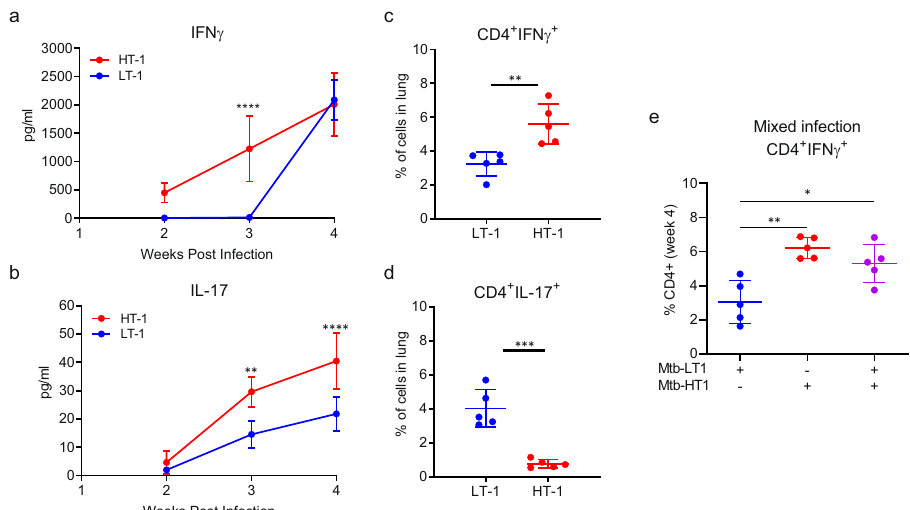
Fig. 4 T cell response is skewed towards Th17 in Mtb-LT infection. C3HeB/FeJ mice were infected with ~100 CFU of the indicated strain via Glas-Col aerosol exposure. IFN γ ( a ) and IL-17A ( b ) protein expression at weeks 2, 3, and 4 post infection was determined by ELISA. Single cell suspensions prepared from the lungs were stimulated for 3 h with Mtb-H37Rv lysate and mycobacterial ESAT-6 and CFP-10 peptide pools and stained with a panel of cell surface antibodies, fi xed and permeabilized, and then stained with a panel of intracellular antibodies. Data are presented as percent of IFN γ + CD4 + ( c ) or IL-17 + CD4 + ( d ) T cells. In a separate experiment Mtb-HT1, Mtb-LT1, and dual Mtb-HT1/LT1 infected mice were evaluated for IFN γ T cells at week 4 post infection ( e ). Data are presented as mean values + / − SD. Source data are provided as a Source Data fi le. Sample size of n = 5 mice was included in each group. Signi fi cance was determined using two-way ANOVA with Bonferroni post-test ( a and b ), unpaired t test ( c and d ) or one-way ANOVA with Tukey ’ s correction ( e ) * P = 0.0134 (panel e ), ** P = 0.0011 (panel b ), ** P = 0.0052 (panel c ) and P = 0.0011 (panel e ), *** P < 0.001, **** P < 0.0001. The experiment was repeated with Mtb-HT2 and